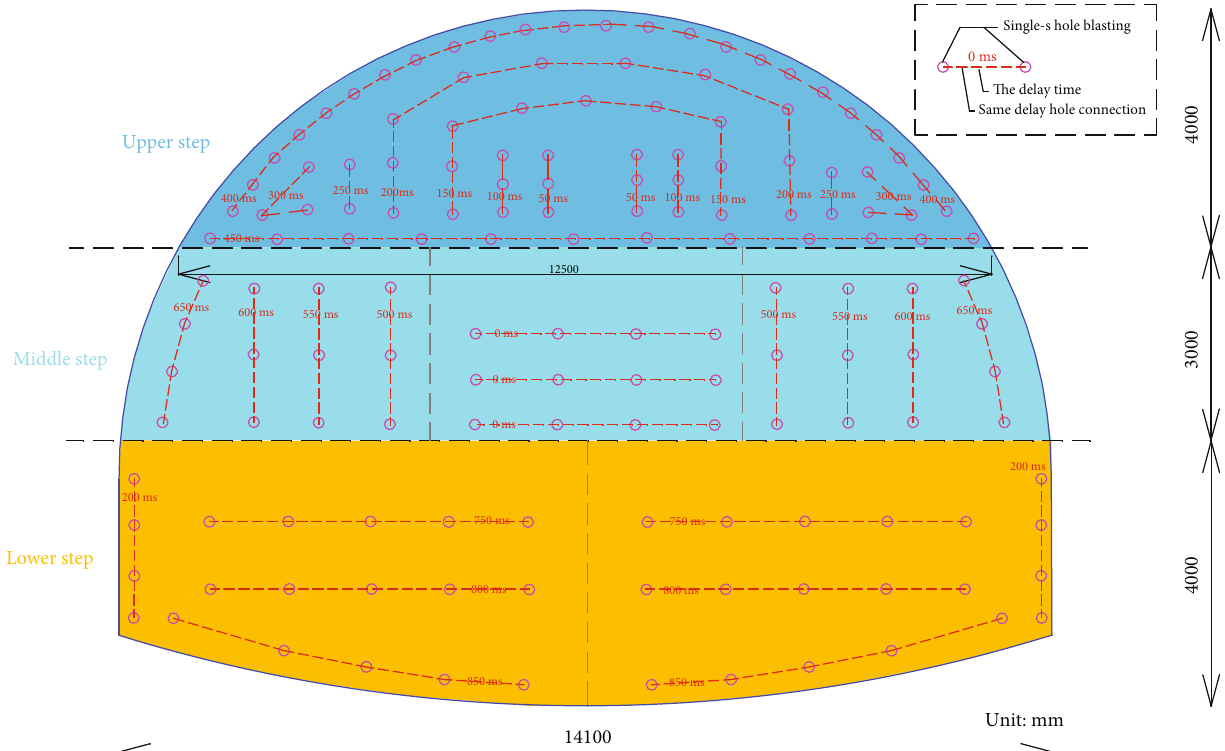
Figure 1: Holes layout and initiation sequence diagram of three-step all-in-one